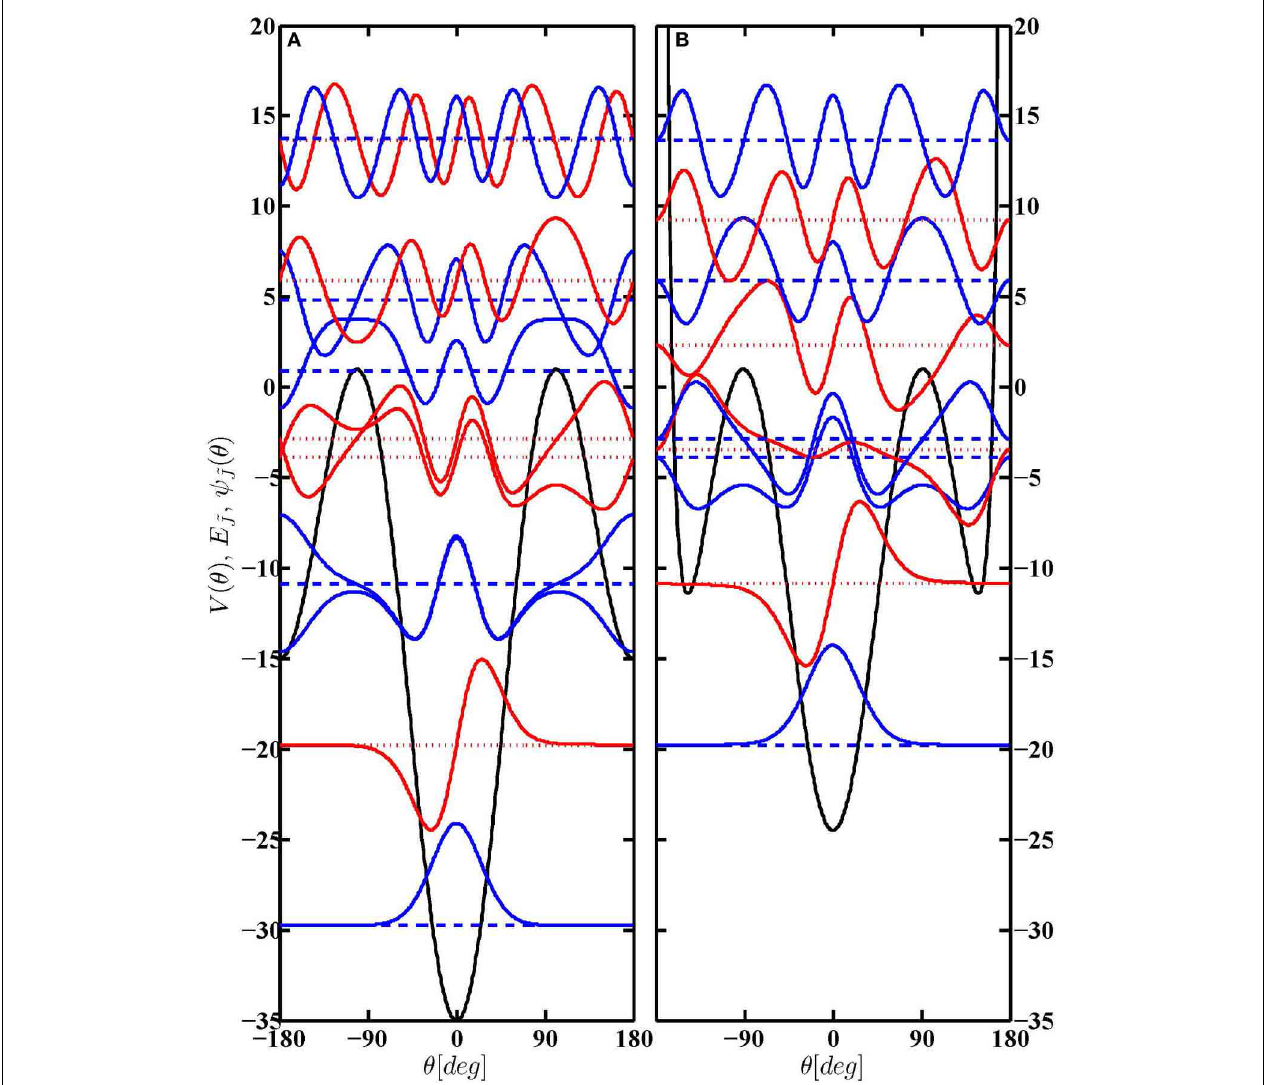
FIGURE 8 | Superpartner potentials V 1 (A) and V + 2 (B), eigenenergies (dashed lines) and eigenfunctions (full curves) of Hamiltonian (Equation 1) with η = 10 ,ζ = 25 for a second-order intersection, κ = 2, see section